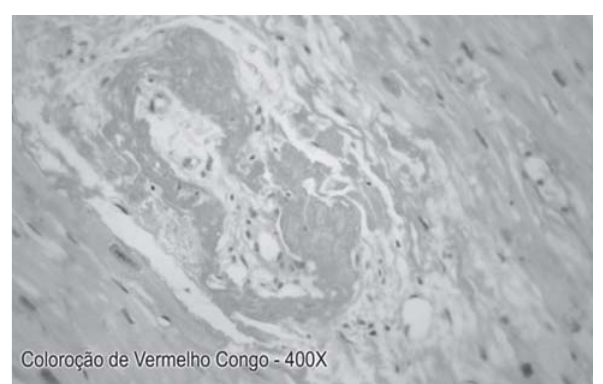
Fig. 2 - Biópsia endomiocárdica demonstrando amiloidose